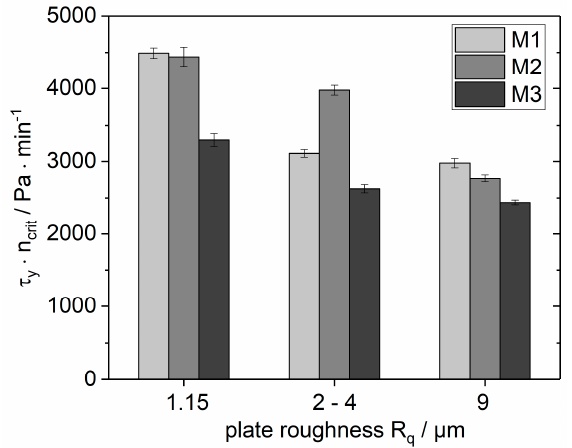
Figure A1. Product of yield stress τ y and critical rotational speed n crit obtained from sample spill investigation at varied plate roughness for M1, M2, and M3.